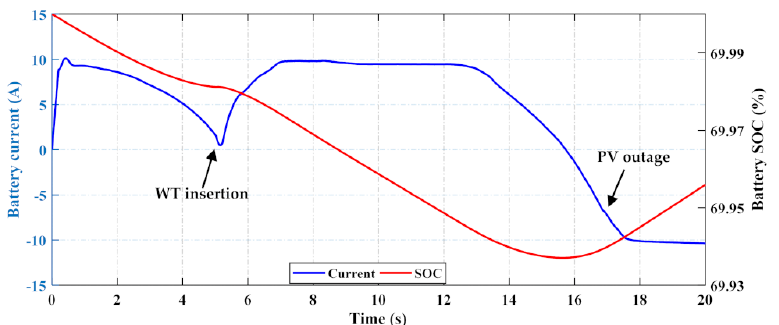
Figure 17. Battery current and SoC using BSS + SMES.